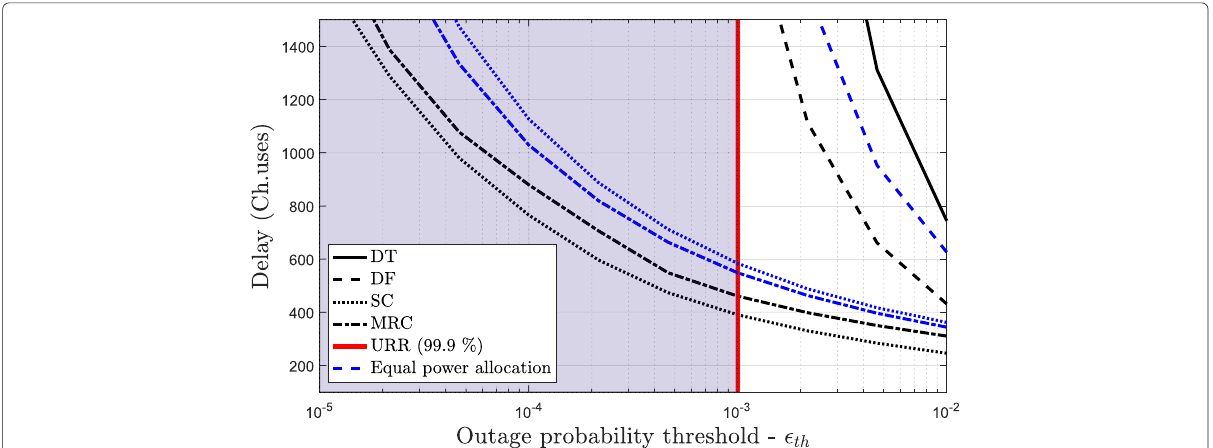
Fig. 8 Total latency in terms of channel uses with EPA and OPA constraints. This figure compares the total minimum latency in cooperative schemes under two distinct power constraints, so-called EPA and OPA. We show that under EPA, MRC has the lowest latency while with OPA, SC